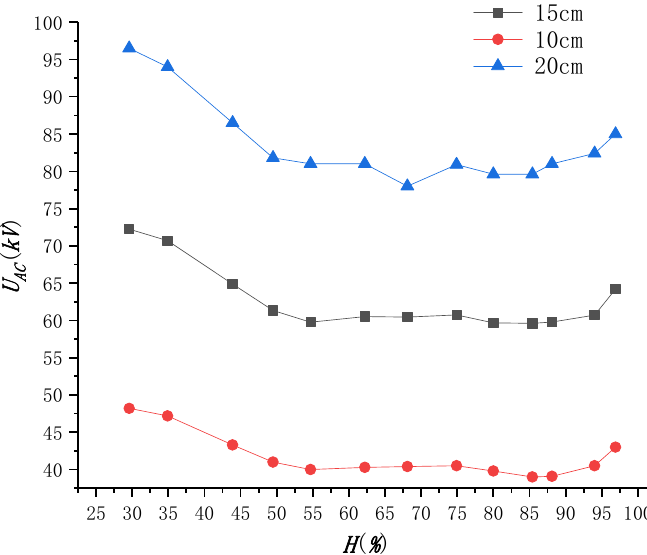
Figure 9. Gap breakdown voltage under different humidity.